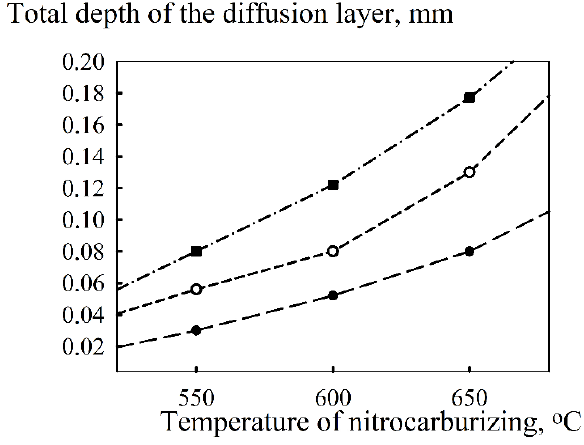
Figure 9. Dependencies of the nitrocarburized layer depth on steel 60Si2Cr on the temperature at the different duration of the process: ● —1 h; ○ —3 h; ■ —5 h.